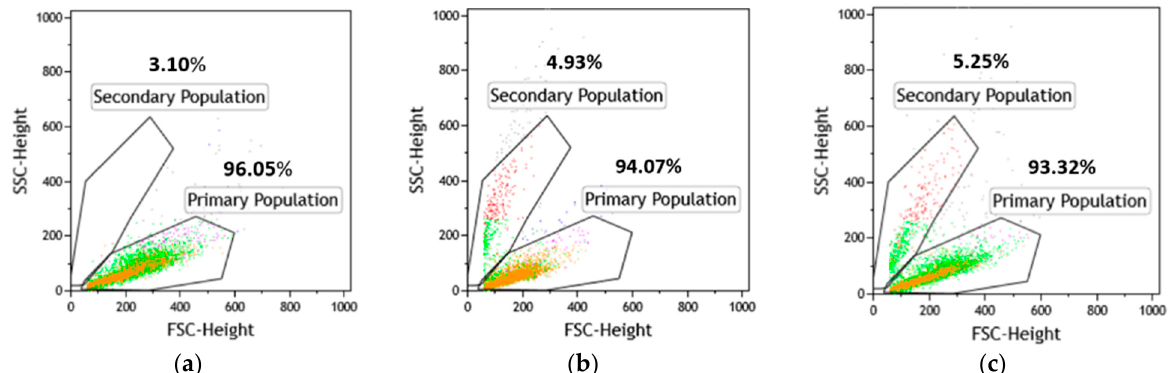
Figure 5. Distinction of morphological classes in unsynchronized yeast populations. Representative FC plots from ( a ) untreated cultures and cultures treated with ( b ) fagopyrin 100 µM, ( c ) hypericin 100 µM. Changes in light-scattering properties of cells exposed to photosensitizers. The primary populations in the treated culture represent cells that have similar light-scattering properties with the untreated population. The secondary populations have diminished forward scatter (FSC) and small cell size with dense structures (SSC).